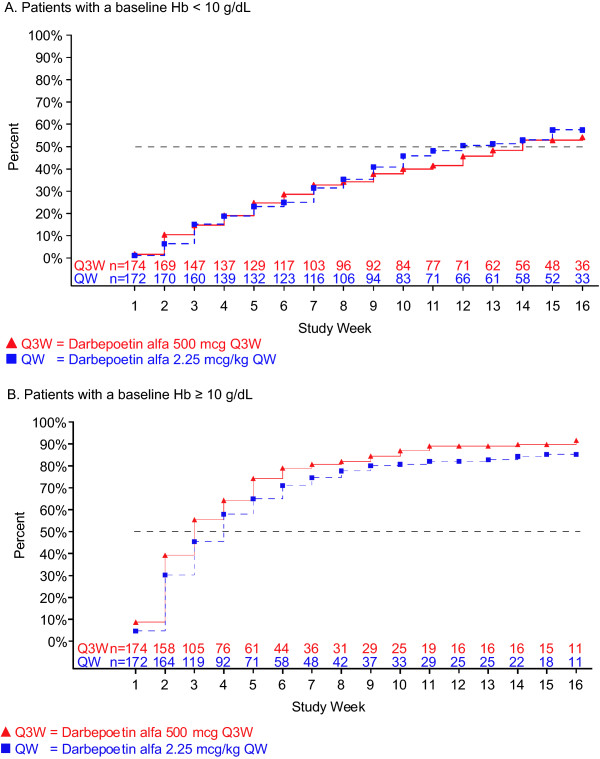
Time to a hemoglobin concentration ≥11 g/dL. Hemoglobin (Hb) measurements within 28 days of a red blood cell transfusion or whole blood transfusion were excluded. Patients not achieving a Hb level ≥11 g/dL between day 1 and end of the treatment period (EOTP, earlier of day 109 or end of study) were censored at their last Hb measurement prior to EOTP. Two patients in the ≥10 g/dL baseline-Hb group who had a baseline Hb level ≥11 g/dL were excluded from the analysis. A. Patients with a baseline Hb level < 10 g/dL. B. Patients with a baseline Hb level ≥10 g/dL.